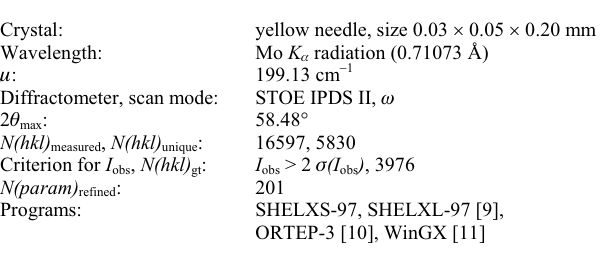
Table 1. Data collection and handling.